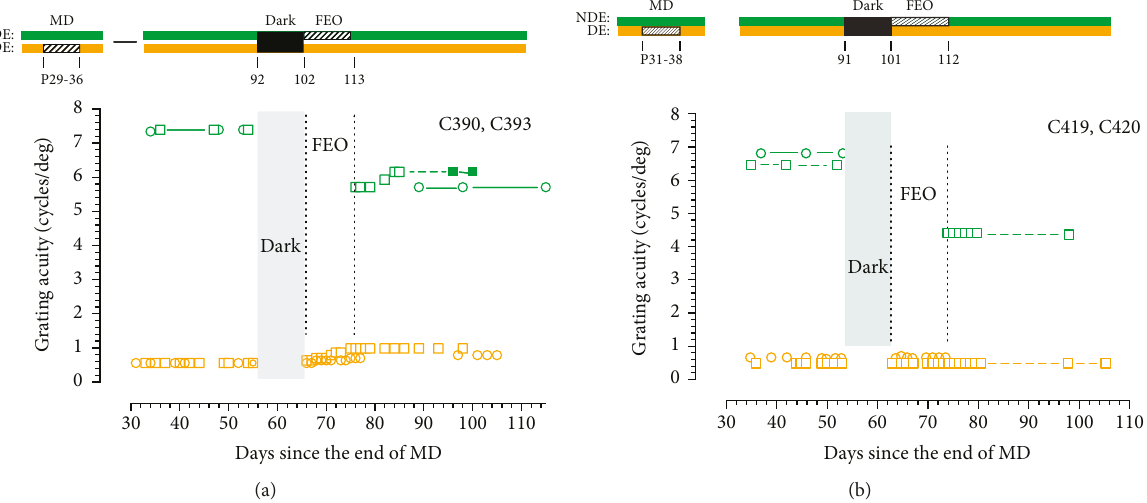
Figure 4: The grating acuity of the deprived (orange symbols) and nondeprived (green solid symbols) eyes as well the binocular acuity (green open symbols) of two pairs of monocularly deprived kittens surrounding 10 days of total darkness followed immediately by an 11-day period of fellow eye occlusion (FEO). As with previous fi gures, the visual histories of the animals are depicted in schematic form by the bars above the two graphs. (a) Data for C390 (square symbols) and C393 (circle symbols). (b) Data for littermates C419 (square symbols) and C420 (circle symbols). The period of FEO e ff ectively blocked any improvement of the acuity of the deprived eye following the period of darkness but did cause a reduction of the acuity of the nondeprived